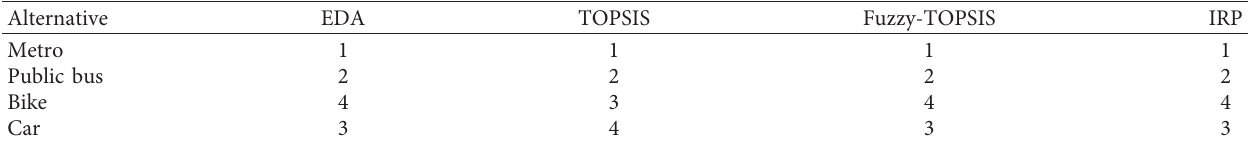
Table 11: Comparison of ranking from different